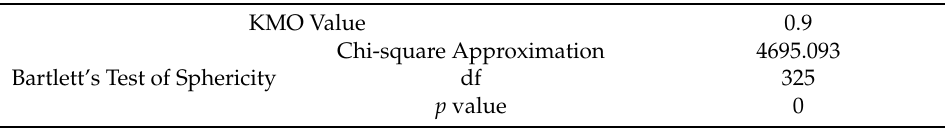
Table 4. KMO and Bartlett